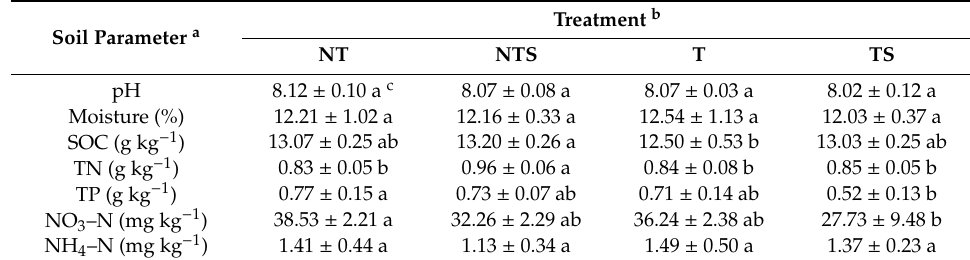
Table 1. Soil physiochemical properties as a ff ected by tillage and crop residue management treatments. Soil Parameter a